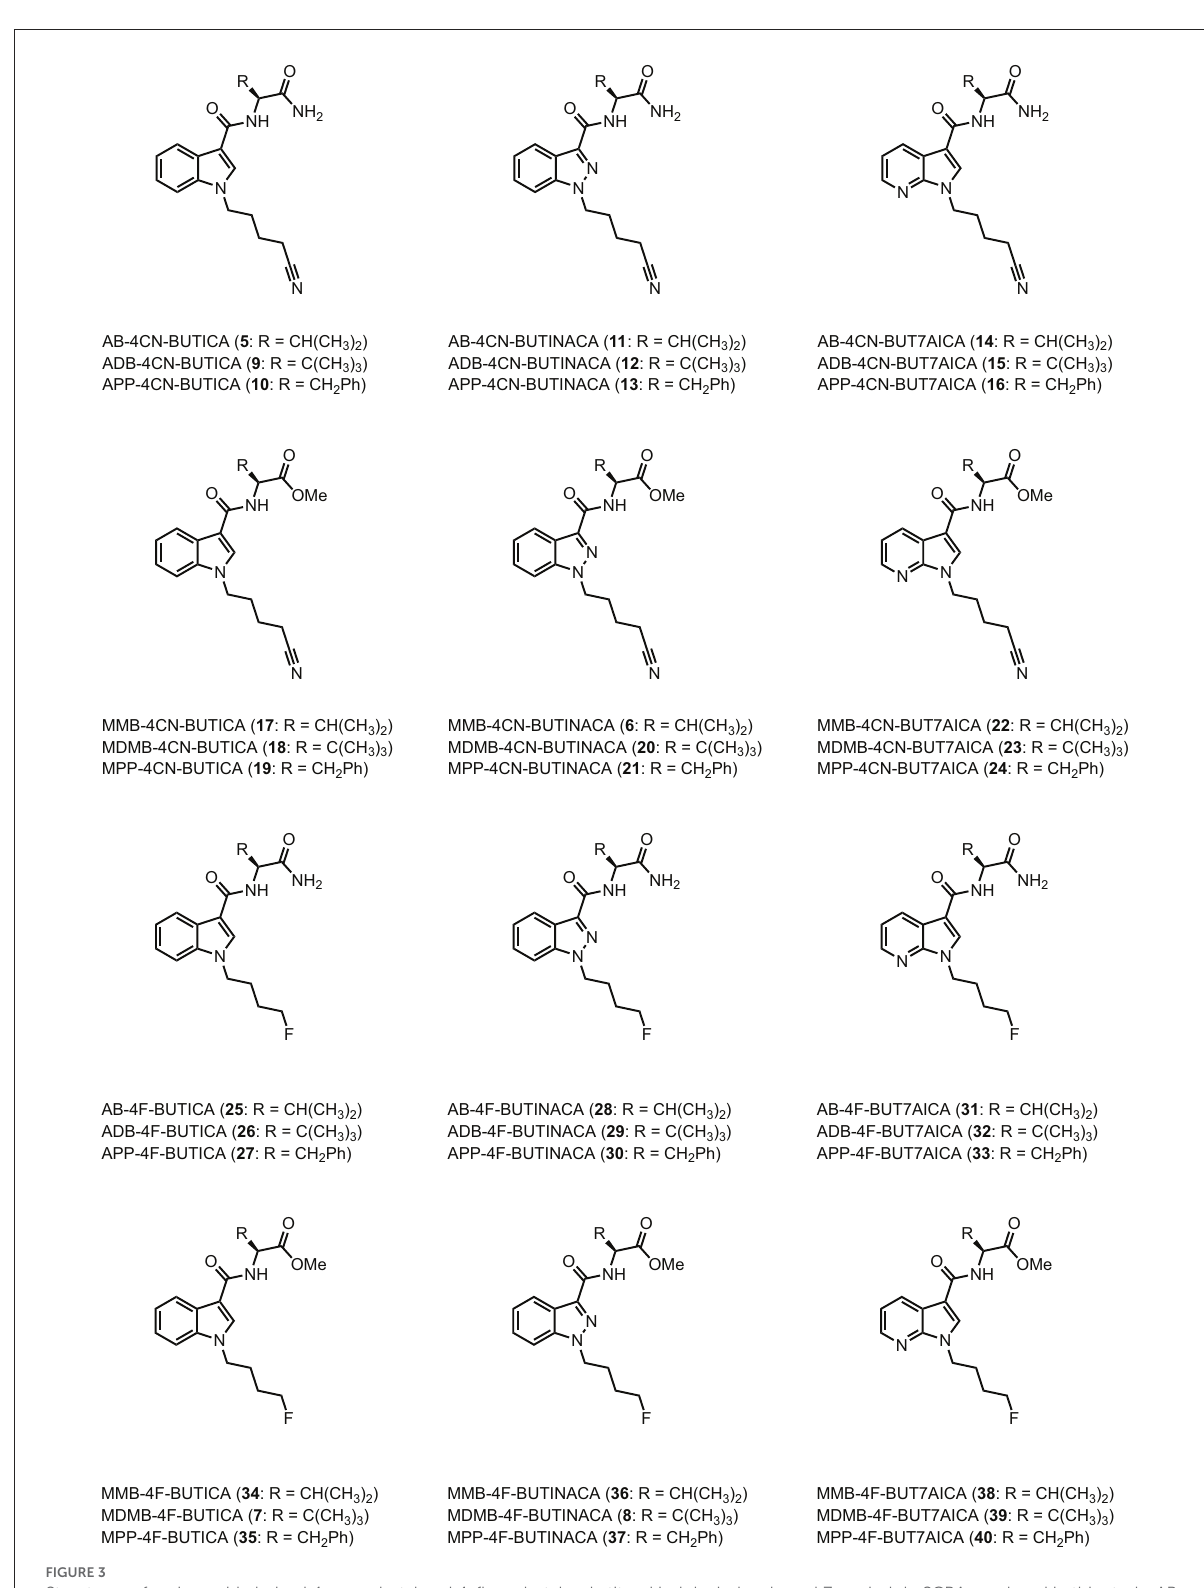
FIGURE3 Structures of amino acid-derived 4-cyanobutyl and 4-fluorobutyl-substitued indole, indazole and 7-azaindole SCRAs explored in this study. AB, [( S )-2-amino-3-methylbutanamide]; ADB, [( S )-2-amino-3,3-dimethylbutanamide]; APP, [( S )-2-amino-3-phenylpropanamide]; MMB, [methyl (S)-2-amino-3-methylbutanoate]; MDMB, [methyl (S)-2-amino-3,3-dimethylbutanoate]; MPP, [methyl (( S )-2-amino-3-phenylpropanoate]; 4-CN-BUT, 4-cyanobutyl; 4F-BUT, 4-fluorobutyl; ICA, indole-3-carboxamide; INACA, indazole-3-carboxamide; 7AICA,